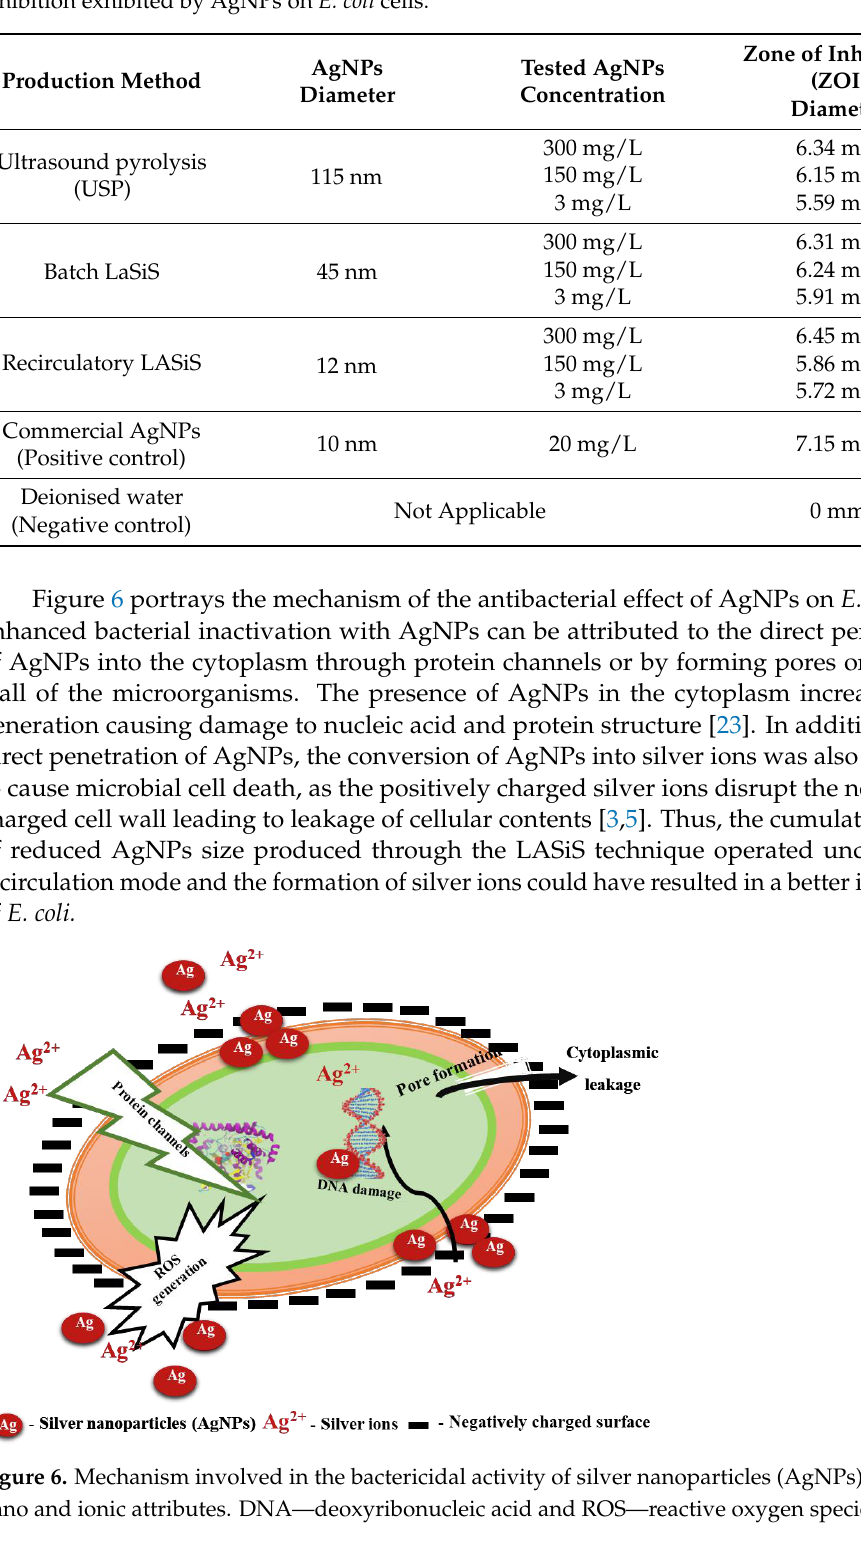
Table 1. Comparison of the size of AgNPs produced through different methods and the zone of inhibition exhibited by AgNPs on E. coli cells.